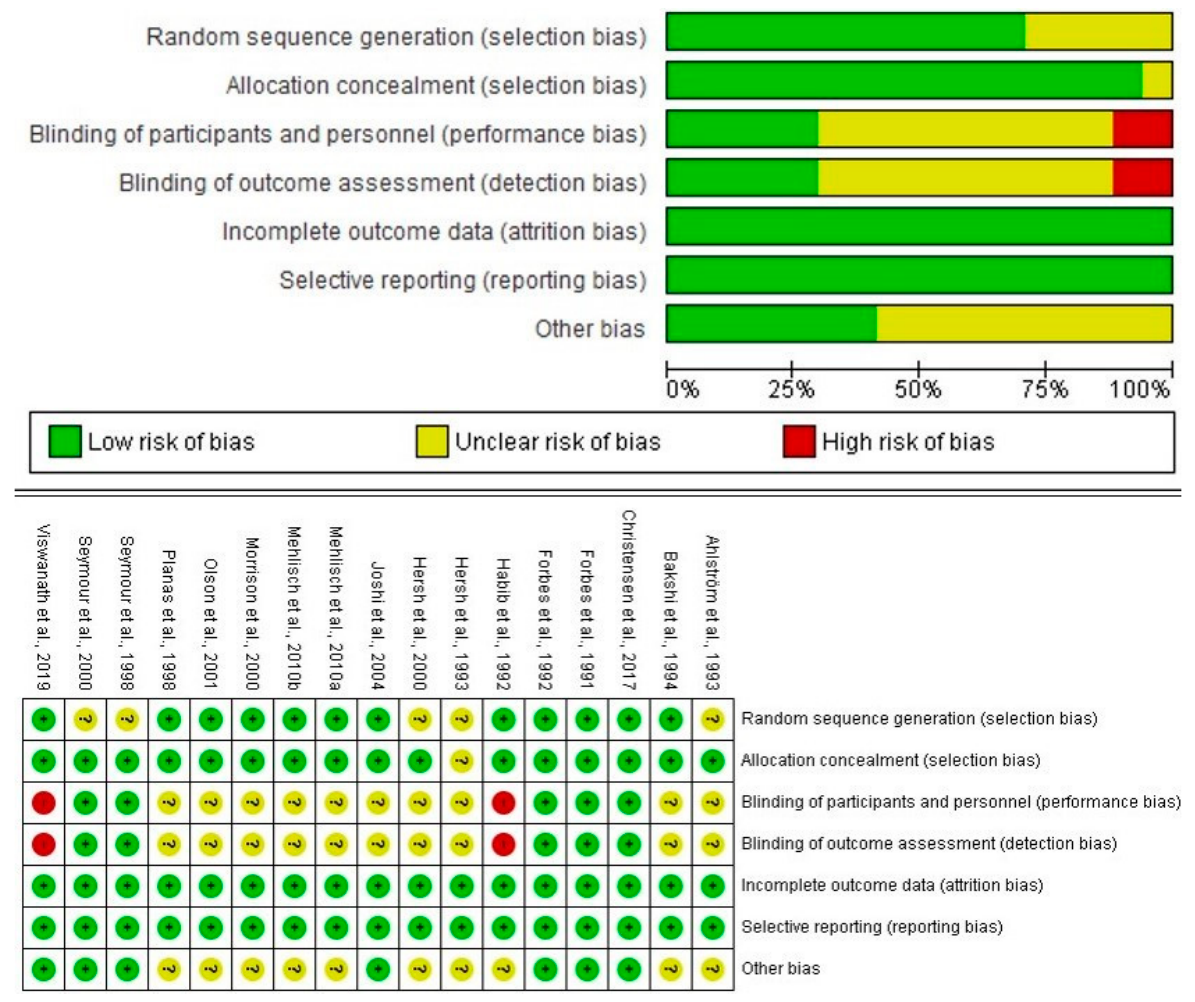
Figure 2. Evaluation of bias of the full ‐ text articles.